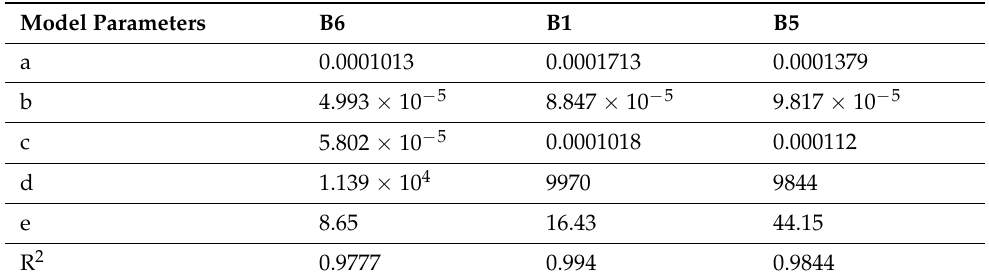
Table 6. Model parameter with fixed values for f_l0 and f_s0, for batteries with a different ∆ SOC. Model Parameters